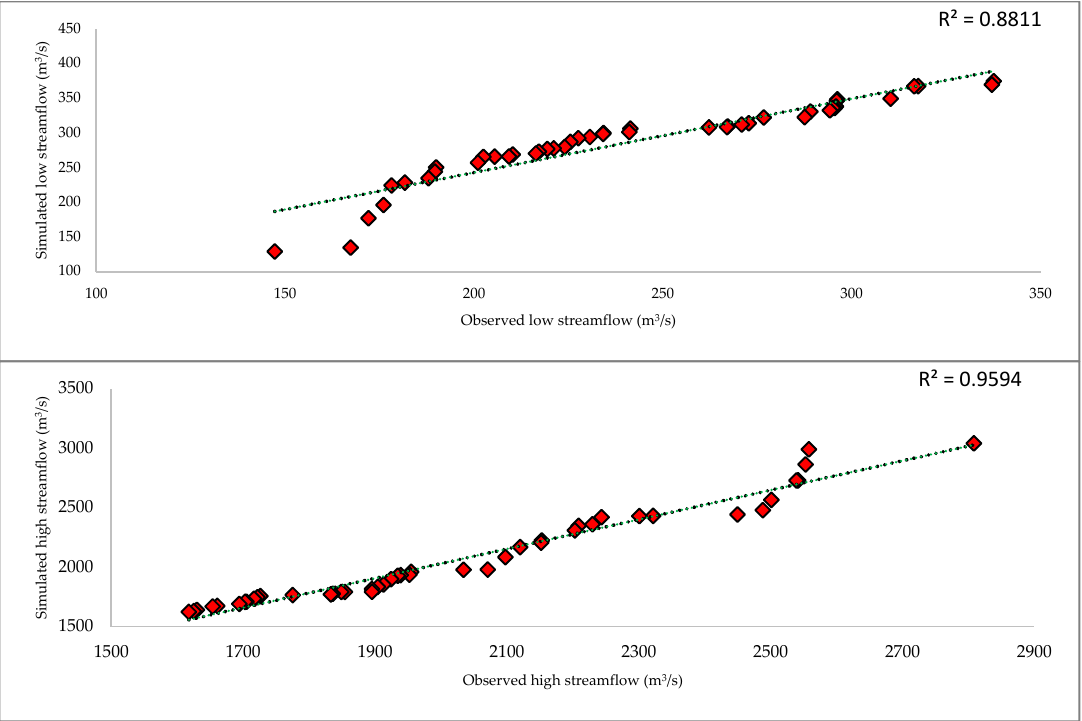
Figure 6. Comparison of observed and simulated low streamflow ( up ) and observed and simulated high streamflow ( down ).